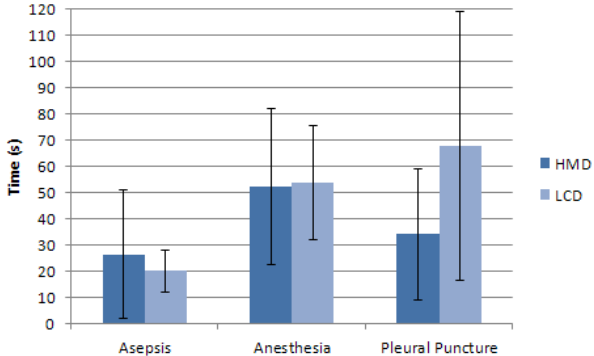
Fig. 16. Average and standard deviation for timings related to the execution of the three main tasks of the pleural tap procedure.